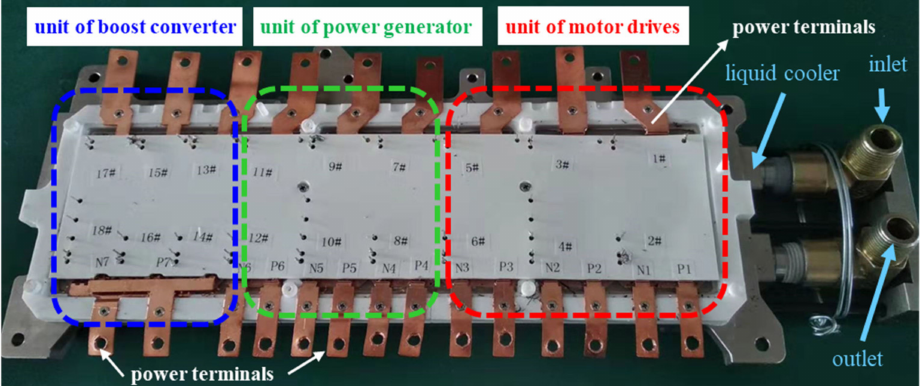
Figure 1. The photo of the developed power control unit (PCU) module. The circuit topology of the developed PCU module is shown in Figure 2. The power converter unit in the blue box is the boost converter (boost unit), the ones in the green box and red box are the power generator (GM_1 unit) and motor drives (GM_2 unit), respectively. There are three phases in each power converter unit. The circuit topology of each phase is a half-bridge configuration. There are two types of power dies on the upper-side or lower-side of each phase, which are the insulated gate bipolar transistor (IGBT) and the anti-parallel fast recovery diode (FRD) dies, respectively.